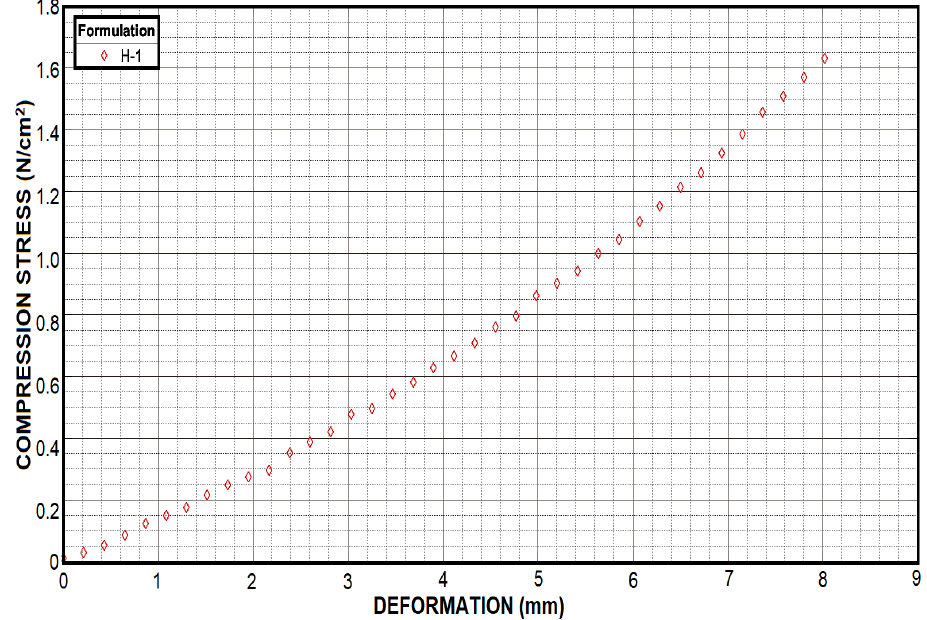
Figure 6. Even if the H-1 formulation does not have a resistance as high as those shown by the other formulations, it was able to double the deformation presented by H-3 and H-5, which translates into greater